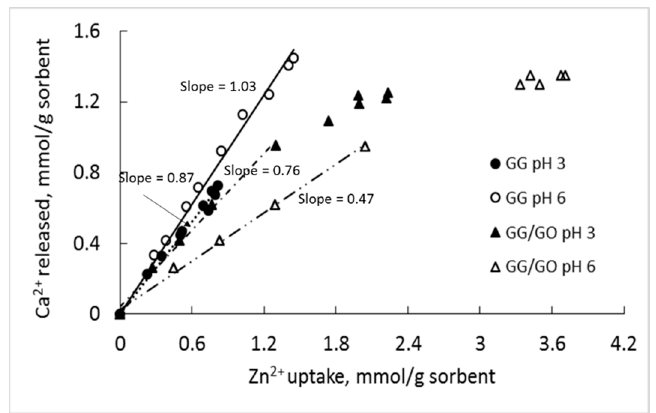
Figure 12. Relationship between zinc ions uptake by sorbents and calcium ions released from the sorbents.